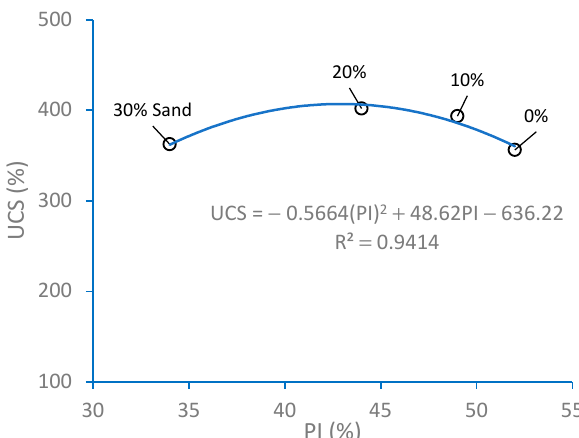
Figure 5. Correlation between UCS and Plasticity index. Table 5. Plasticity characteristics for clay-sand mixes.